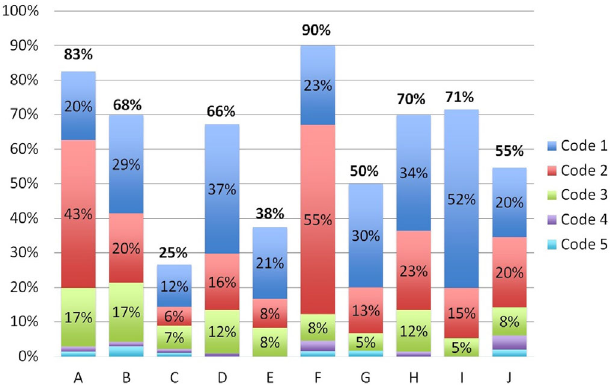
FIG. 3. The distribution of social positions for each group in “ scale tilt ” activity, episode 1. Columns represent percentage of 1, 2, 3, 4, and 5 codes as a fraction of total number of codes, scaled by the amount of coded time.